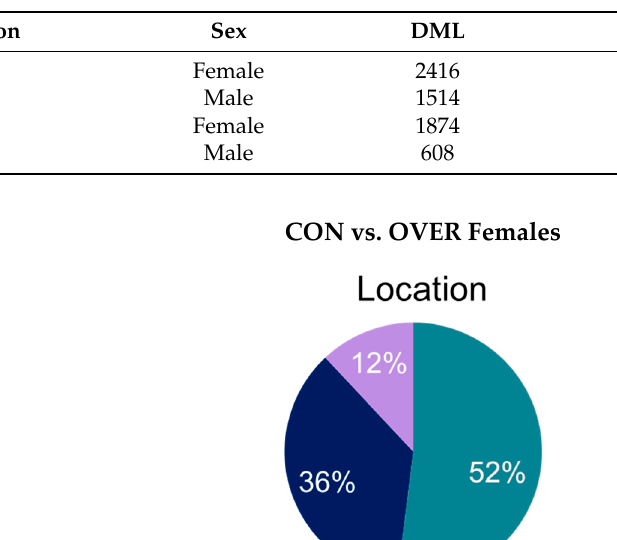
Table 2. Offspring pancreas tissue DML and DMRs.